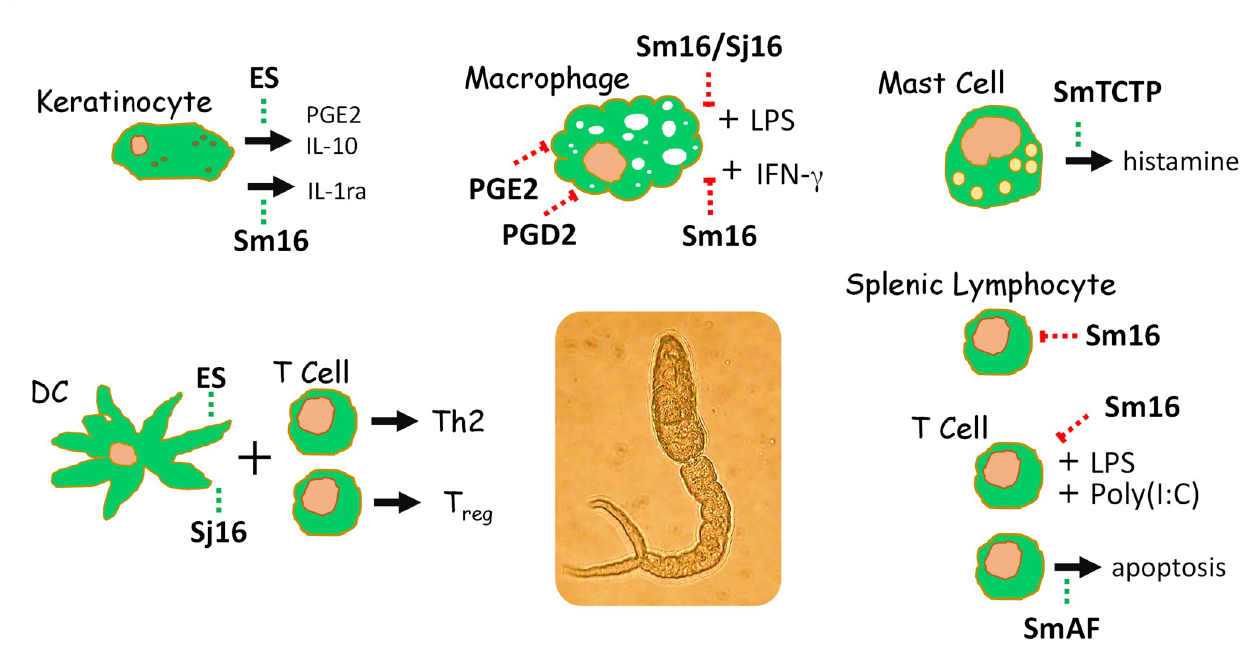
Fig 1. The impact of molecules (bold text) produced by schistosome larvae (cercariae and/or schistosomula) on the host cells indicated. An image of an S . mansoni cercaria is seen at the center. The green dashed lines indicate stimulatory effects, while red dashed lines indicate inhibitory effects. See text for details regarding the impact of individual schistosome molecules on specific cell types. DC, dendritic cell; ES, excretions/secretions; IFN γ , interferon gamma; IL-10, interleukin 10; IL-1ra, IL-1 receptor antagonist a; LPS, lipopolysaccharide; PGE2, prostaglandin E2; PGD2, prostaglandin D2 SmAF, S . mansoni apoptosis factor; SmTCTP, S . mansoni translationally controlled tumor